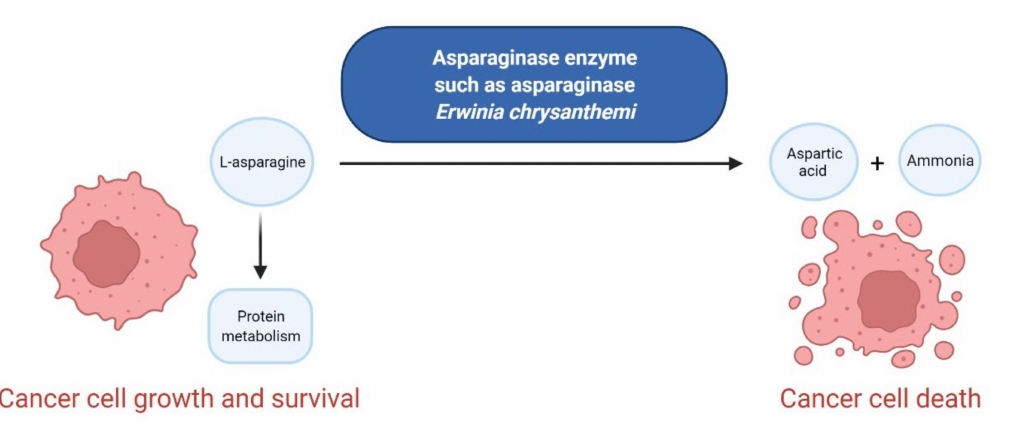
Figure 13. Schematic representation of mechanism of action for asparaginases such as asparaginase Erwinia chrysanthemi and calaspargase pegol-mknl. Created with